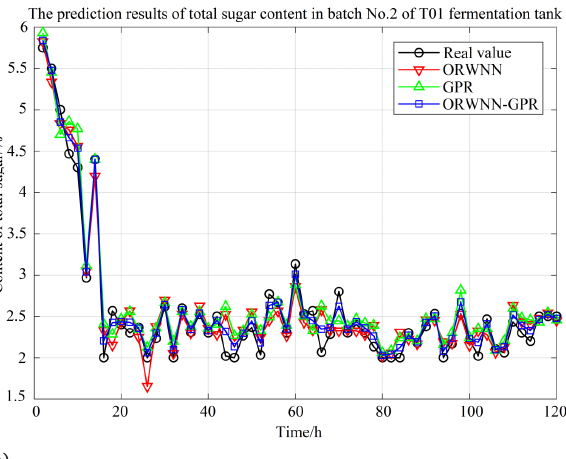
Figure 2: Flow chart of cumulative update training algorithm.